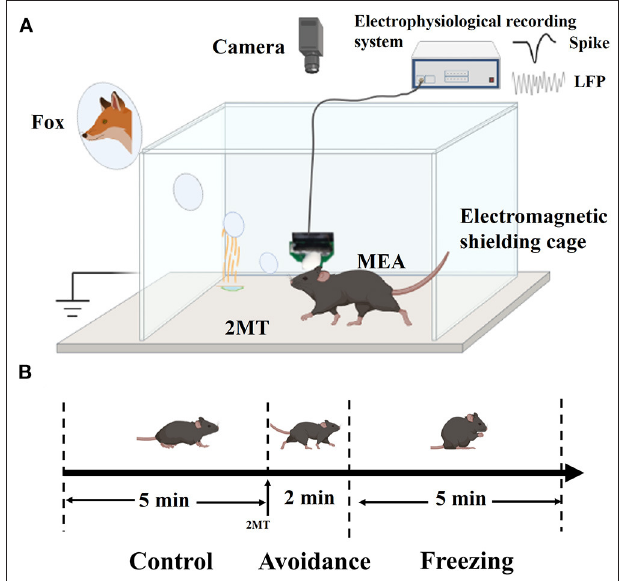
FIGURE 2 | Schematic diagram of experiment platform and experimental flow. (A) Schematic diagram of experiment platform; (B) Three behavioral stages in the experimental